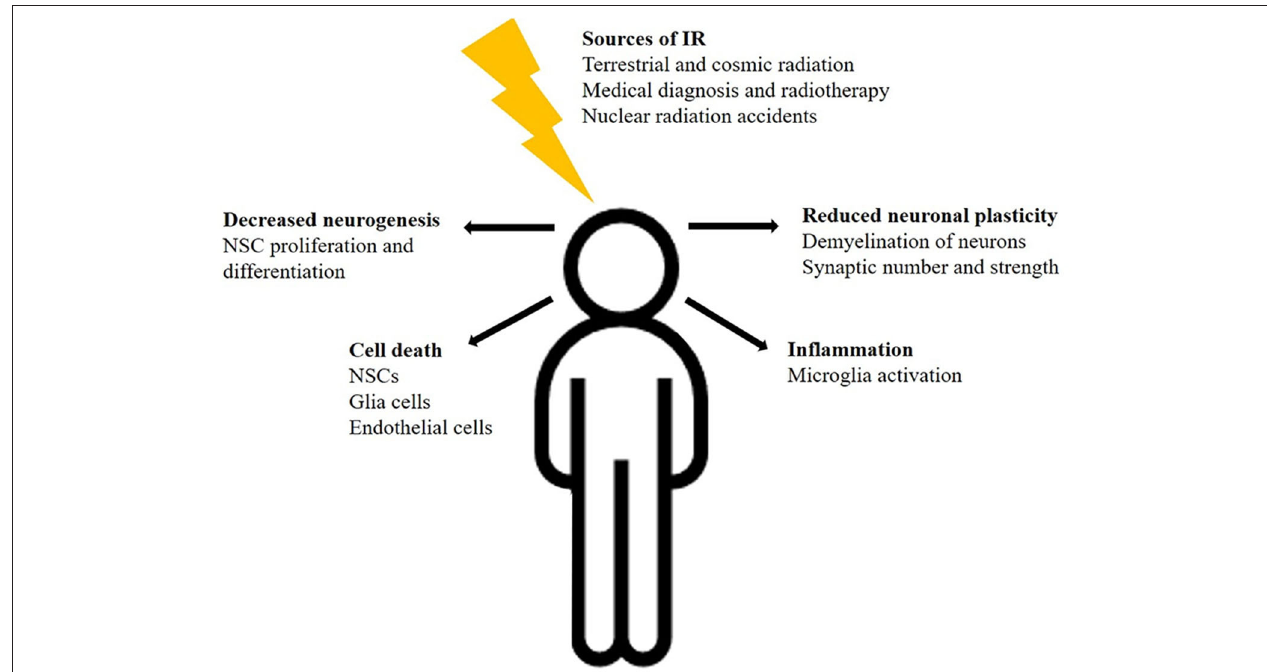
FIGURE 1 | Schematic illustration of IR-sources and possible radiation effects on the human